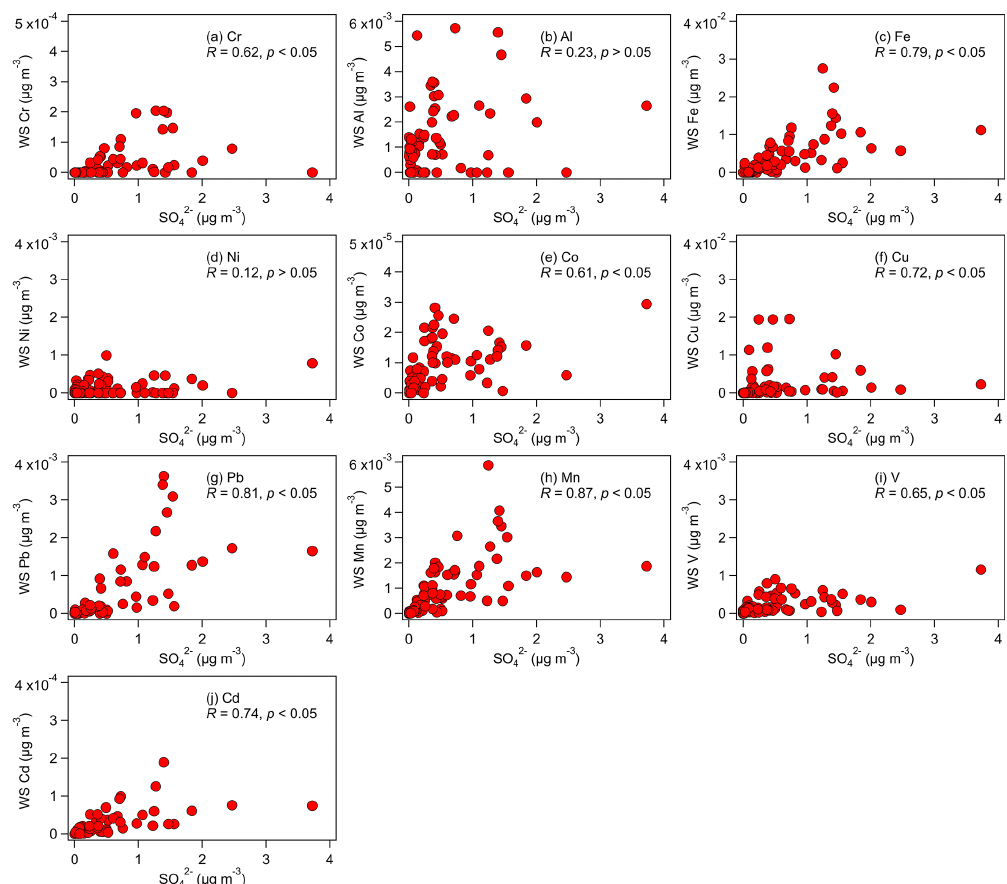
Figure 5. Relationships between the mass concentrations of water-soluble (WS) metals and sulfate in fine aerosols. Only data with nonzero total metal concentrations were used in the figures. Also shown are the Spearman correlation coefficients for each relationship.